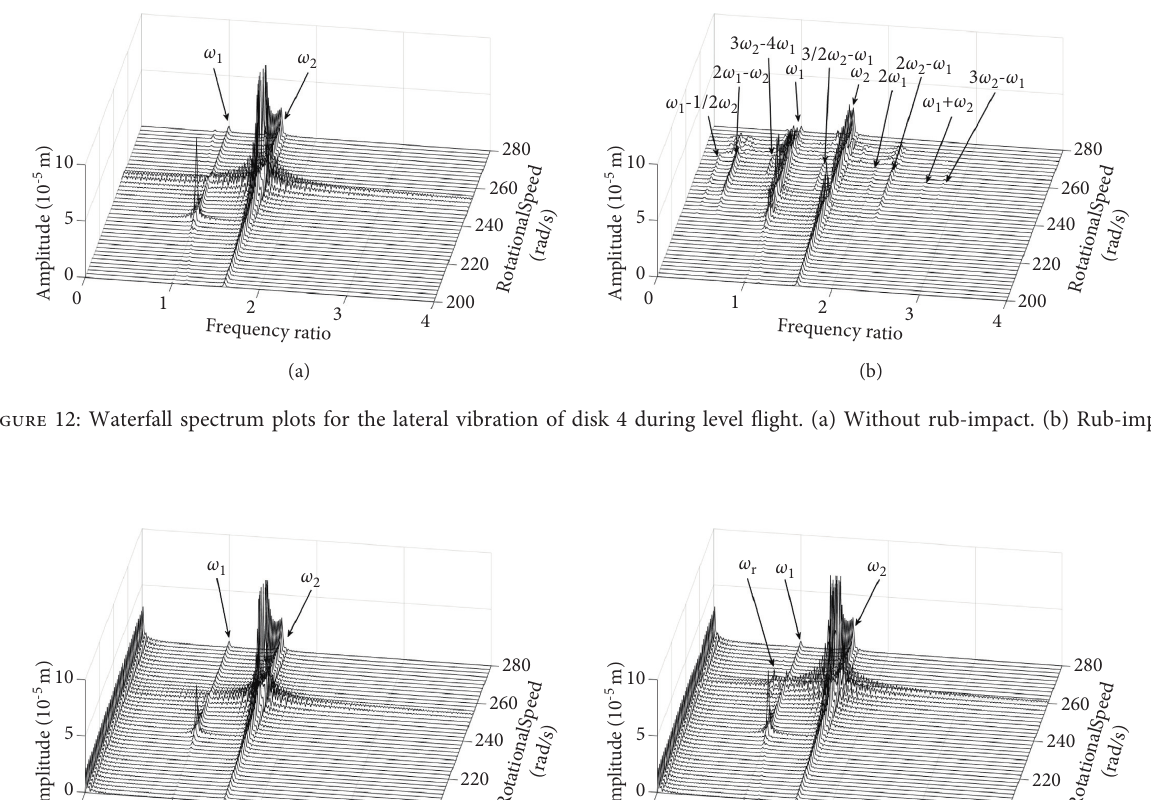
and some combinational frequencies are produced by the rub-impact, such as 2 ω − 2 ω 3 ω , etc. 2 1